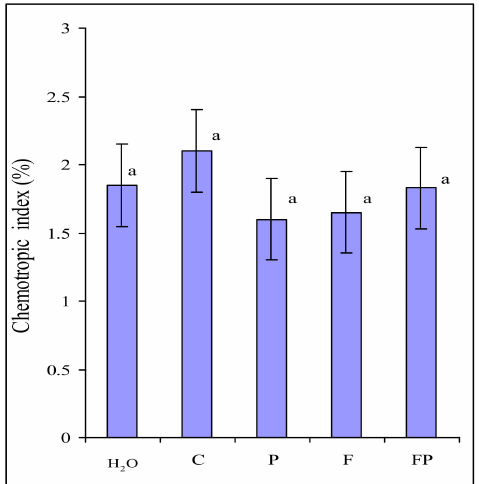
Figure 1. Directed growth of Fusarium culmorum macroconidia germ tubes to water (H 2 O) and to exudates of: control barley (C), barley colonized by Pseudomonas fluorescens (P), barley colonized by F. culmorum (F), barley colonized by both P. fluorescens and F. culmorum (FP). Data are presented as the mean from two experiments. n = 600 germ tubes. Error bars show standard deviation. Values of di ff erent letters are significantly di ff erent at p ≤ 0.05 when applying Fisher’s LSD